Question: Give a one-sentence summary of this figure.
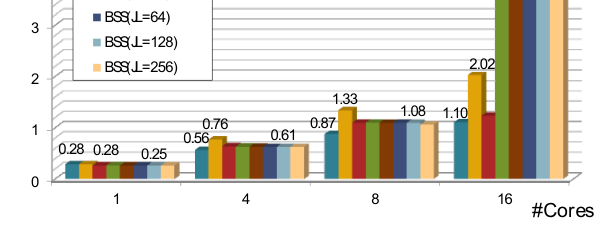
Answer: Performance of BSS   (U3) in 16 threads of the T2K (1 node).